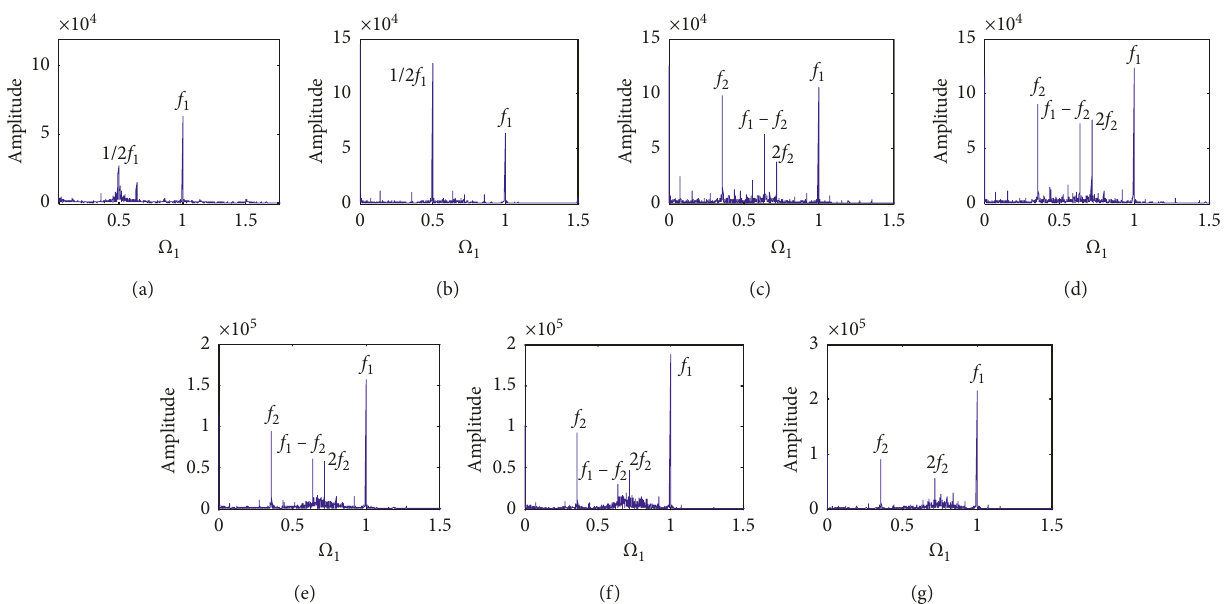
Figure 17: Frequency spectra for each clearance when Ω e � e � 0.8, (f) e a1 a2